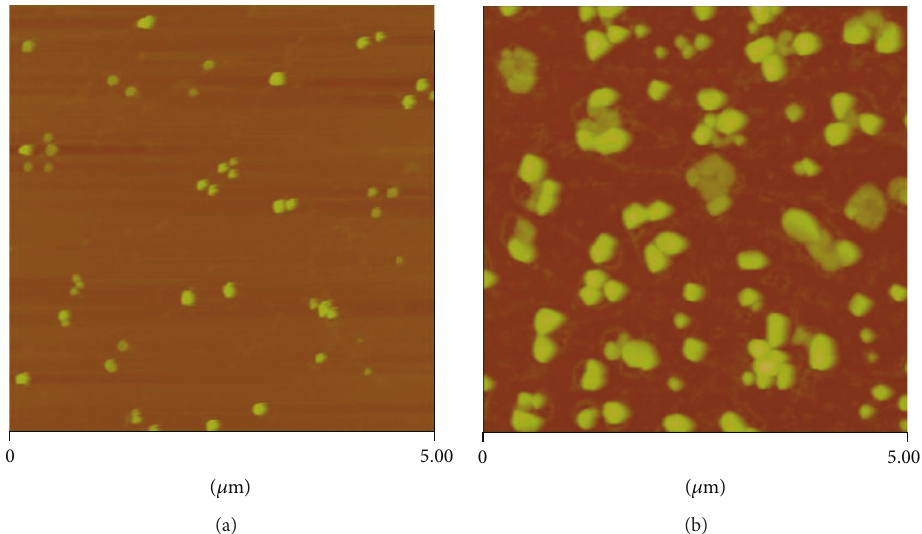
Figure 5: AFM images of DPG at different shearing rates. (The scanned area in Figure 6 is 5 × 5 𝜇 m.).